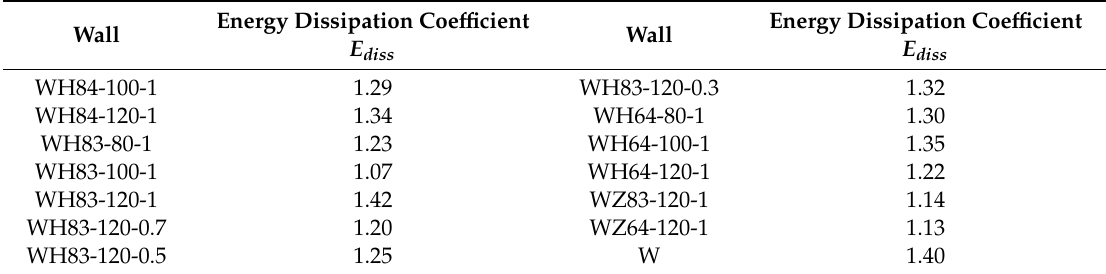
Table 7. Energy dissipation coe ffi cient of the